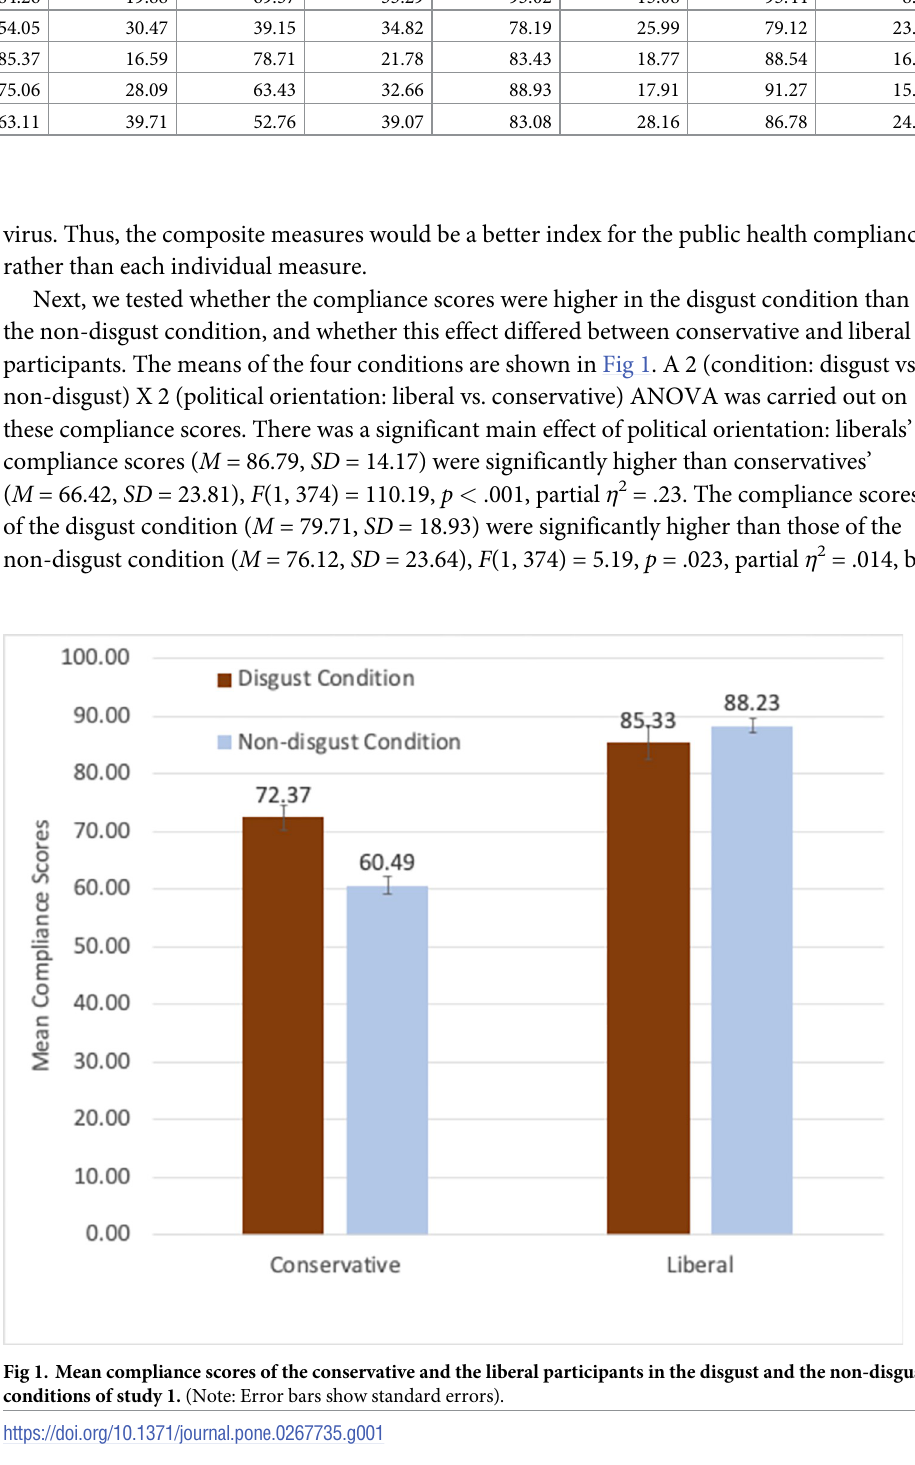
Fig 1. Mean compliance scores of the conservative and the liberal participants in the disgust and the non-disgust conditions of study 1. (Note: Error bars show standard errors).